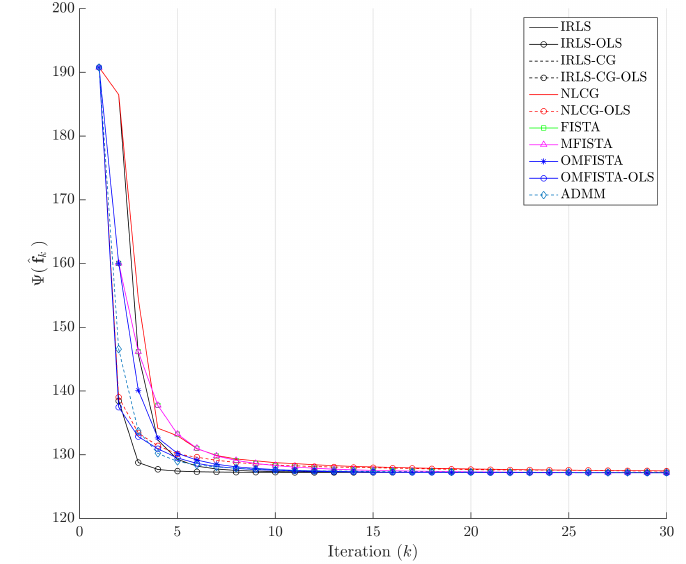
Figure 18. Cost function Ψ ( ˆ f k ) versus iteration number k —Real dataset.